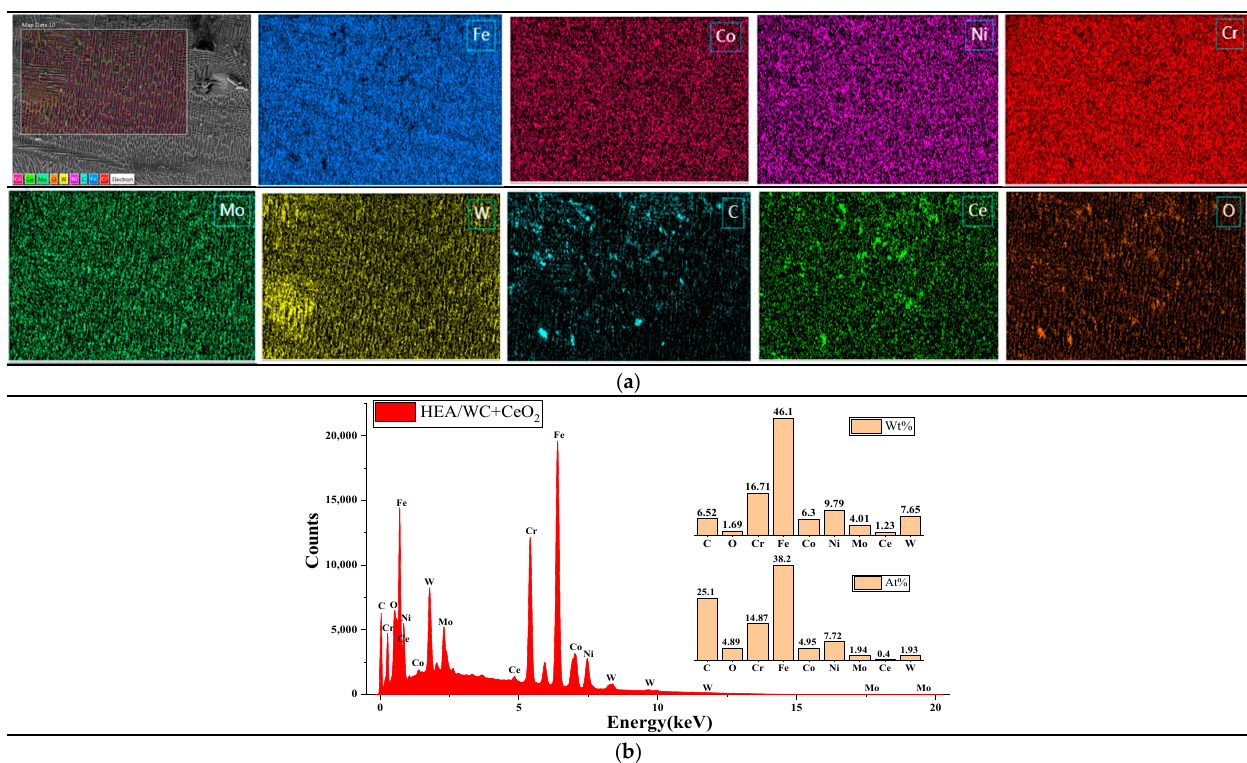
Figure 7. ( a ). The energy spectrum analysis results of each element of the HEA/WC + CeO2 coating. ( b ). The distribution of each element of the HEA/WC + CeO 2 coating.